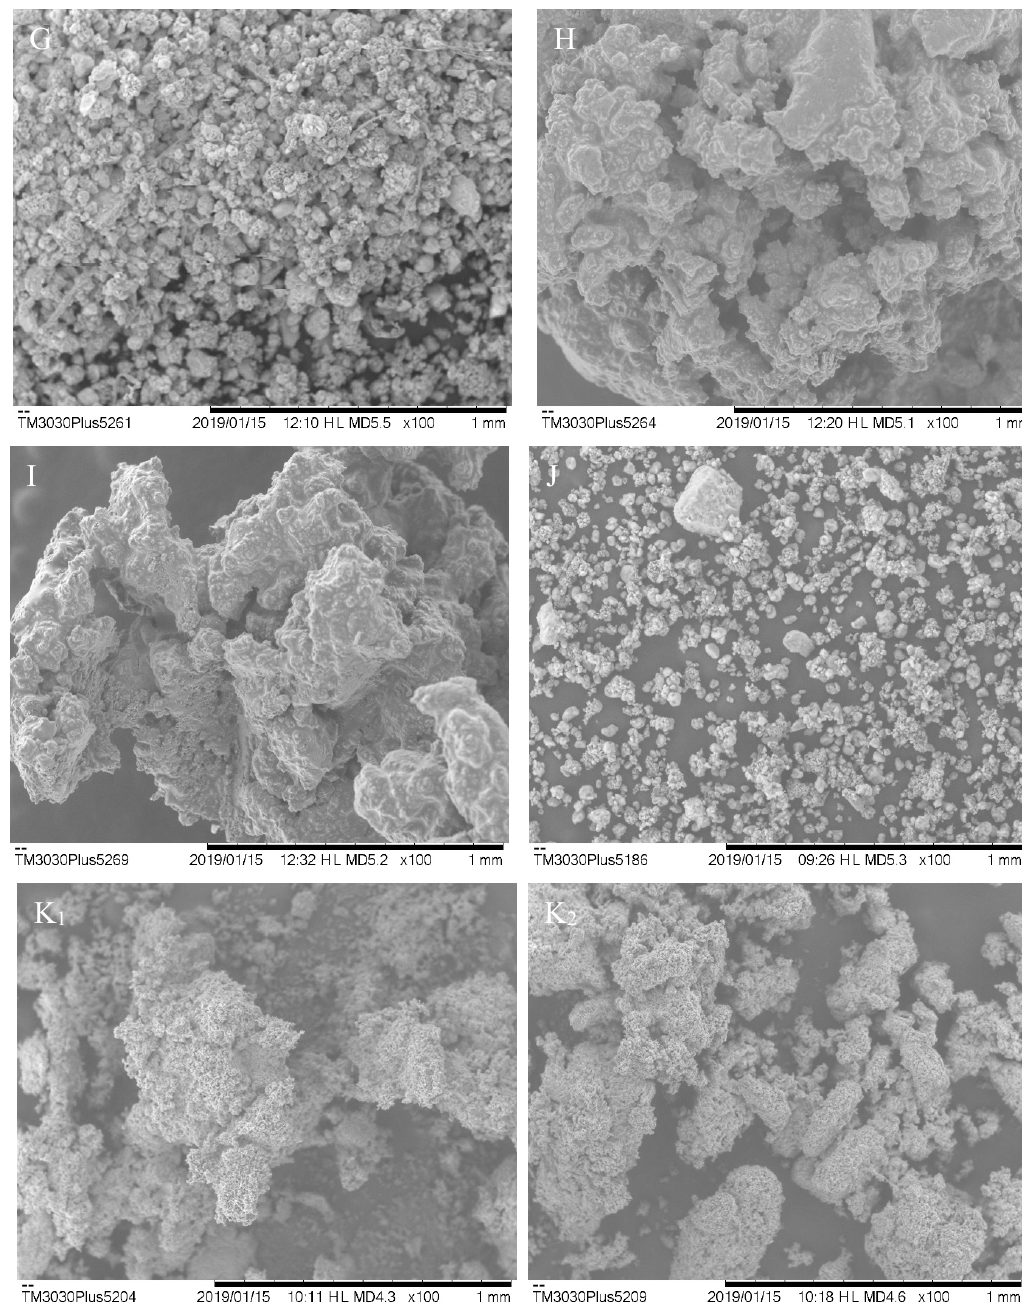
Figure 1. Images obtained by SEM of the dried extracts, which were subscribed as number 1 (indicates the images of samples obtained in the cyclone) and number 2 (those obtained in the collector). ( A ) Sample 01, ( B ) Sample 02, ( C ) Sample 03, ( D ) Sample 04, ( E ) Sample 05, ( F ) Sample 06, ( G ) Sample 07, ( H ) Sample 08, ( I ) Sample 09, ( J ) ESA, and ( K ) ESB P. olacoides. The particles presented an average size that ranges between 0.089 and 0.308 µm. These differences in size are related to the morphological irregularities present in the particles and may be associated with the evaporation rates of water and solvent (ethanol) during the spray-drying process